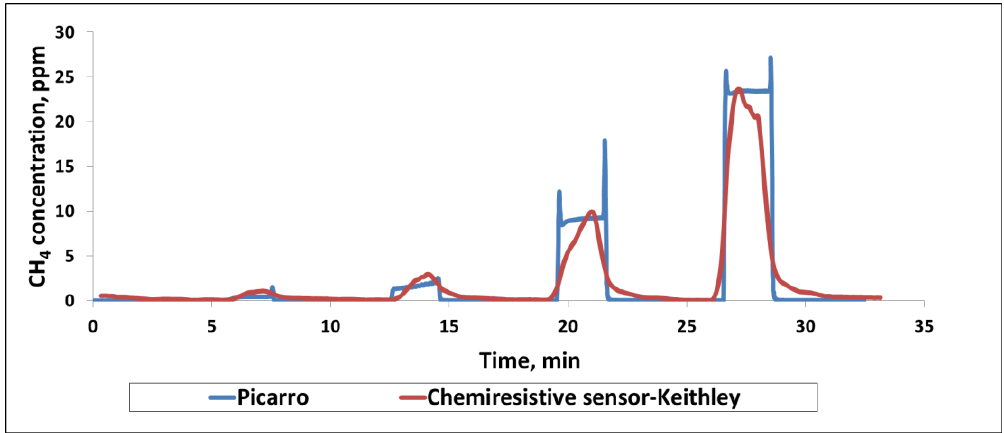
Figure 4. Picarro CRDS and chemiresistive sensor responses from the Keithley instrument for sufonated nanotubes to various ppm level concentrations of CH 4 .